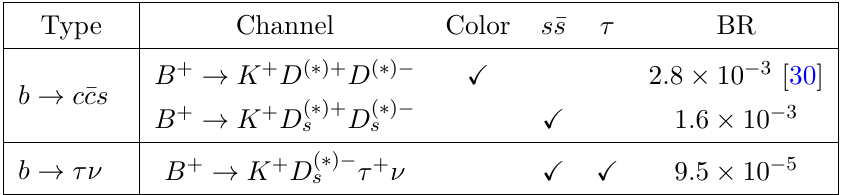
Table 7 . Major backgrounds for the B + → K + τ + τ − measurement. “Color”, “ s ¯ s ” and “ τ ” represent the three effects suppressing the B -meson decays which are discussed in the